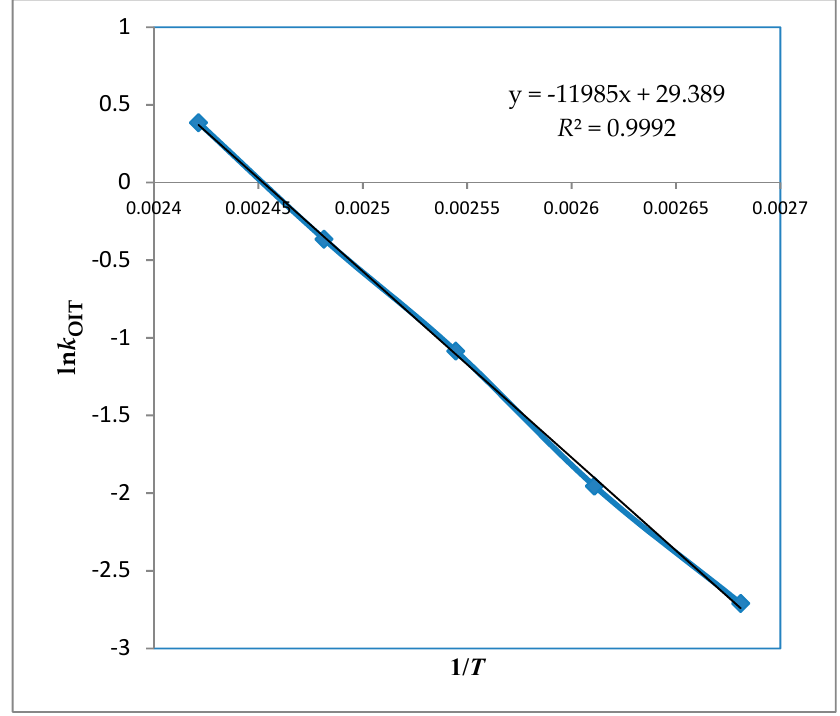
Figure 1. ln ( k ) vs. 1/ T which illustrates the activation energy and pre-exponential factor where the slope is used for the calculation of E a while the intercept is used for the calculation of A (frequency factor).